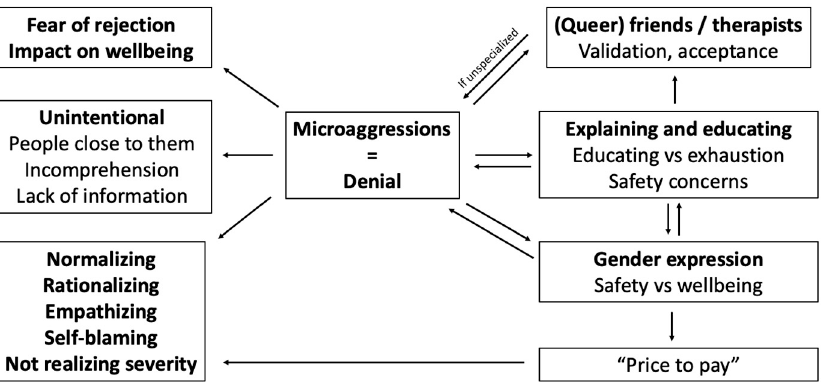
Figure 1. Experiences of microaggressions among NGBQ youth. This figure summarizes the main experiences of NBGQ youth with microaggressions and how different elements of these experiences relate.